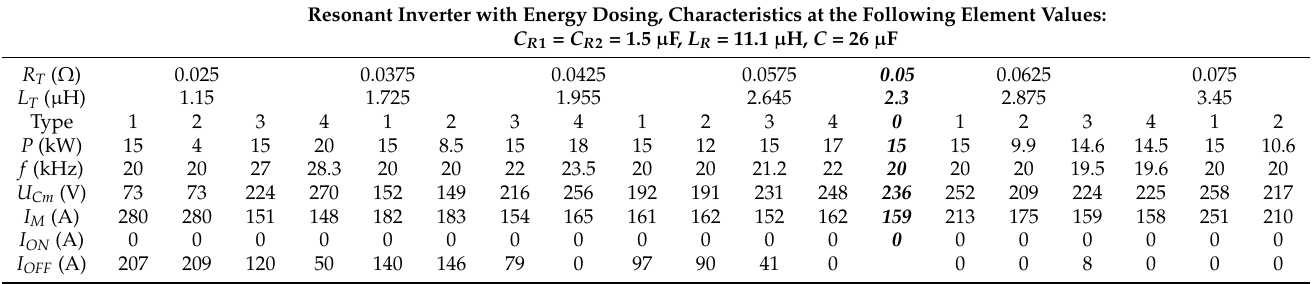
Table 1. Characteristics of the RI with